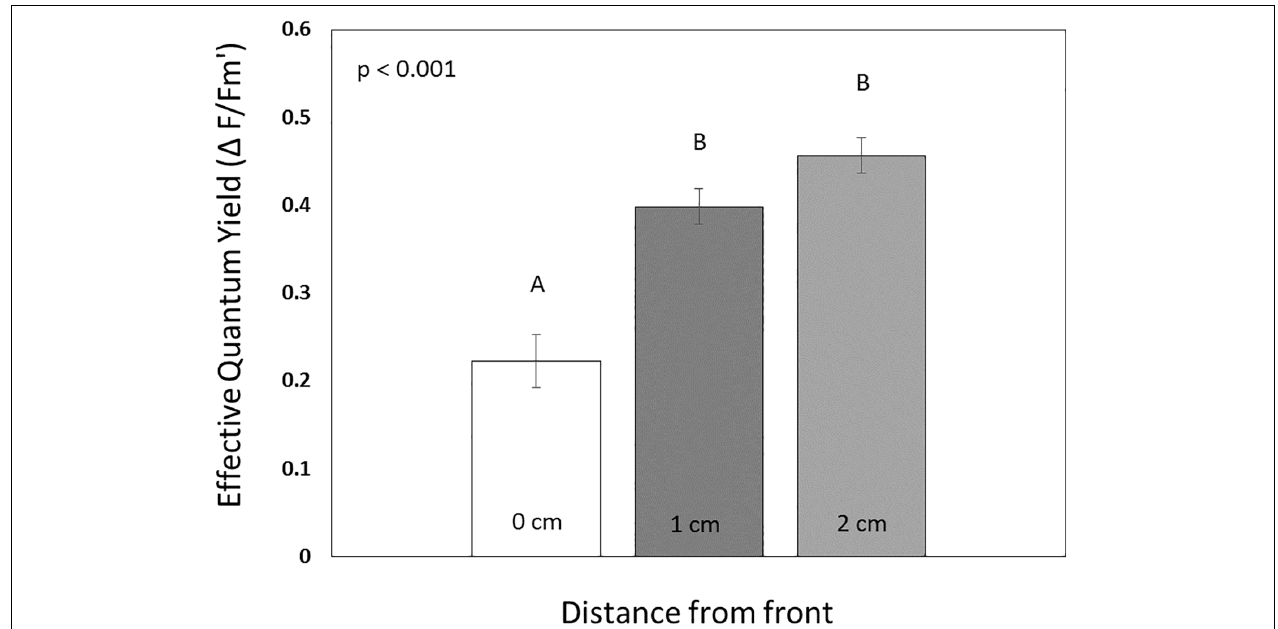
FIGURE 7 | Comparisons of effective quantum yields (means ± SE, n = 16) for tissue at (0 cm removed), adjacent (1 cm), and removed (2 cm) from the disease front in Montastraea cavernosa . Statistical results of a repeated measures ANOVA are displayed. Bars with distinct lettering are significantly different (Sidak post hoc test).